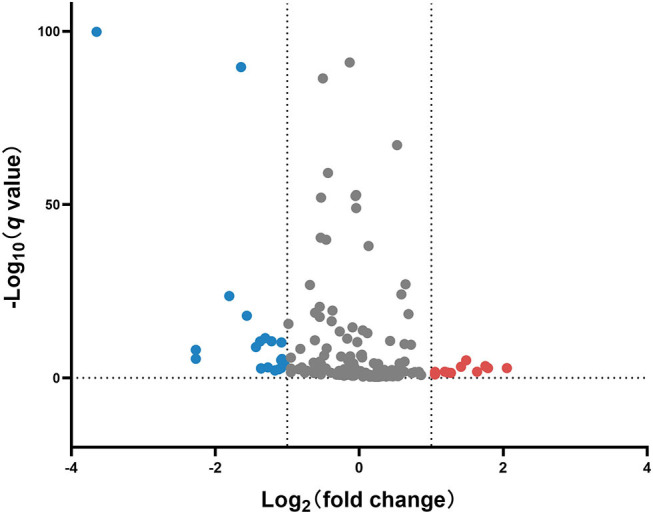
Volcano plot of differentially expressed miRNAs in the ovary of ESA and ESI crabs. Gray, red, and blue dots represent non-significant, upregulated, and downregulated miRNAs after ESA, respectively.